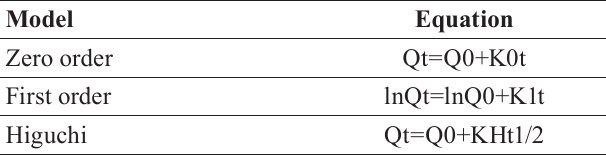
TABLE II - Kinetics of drug release